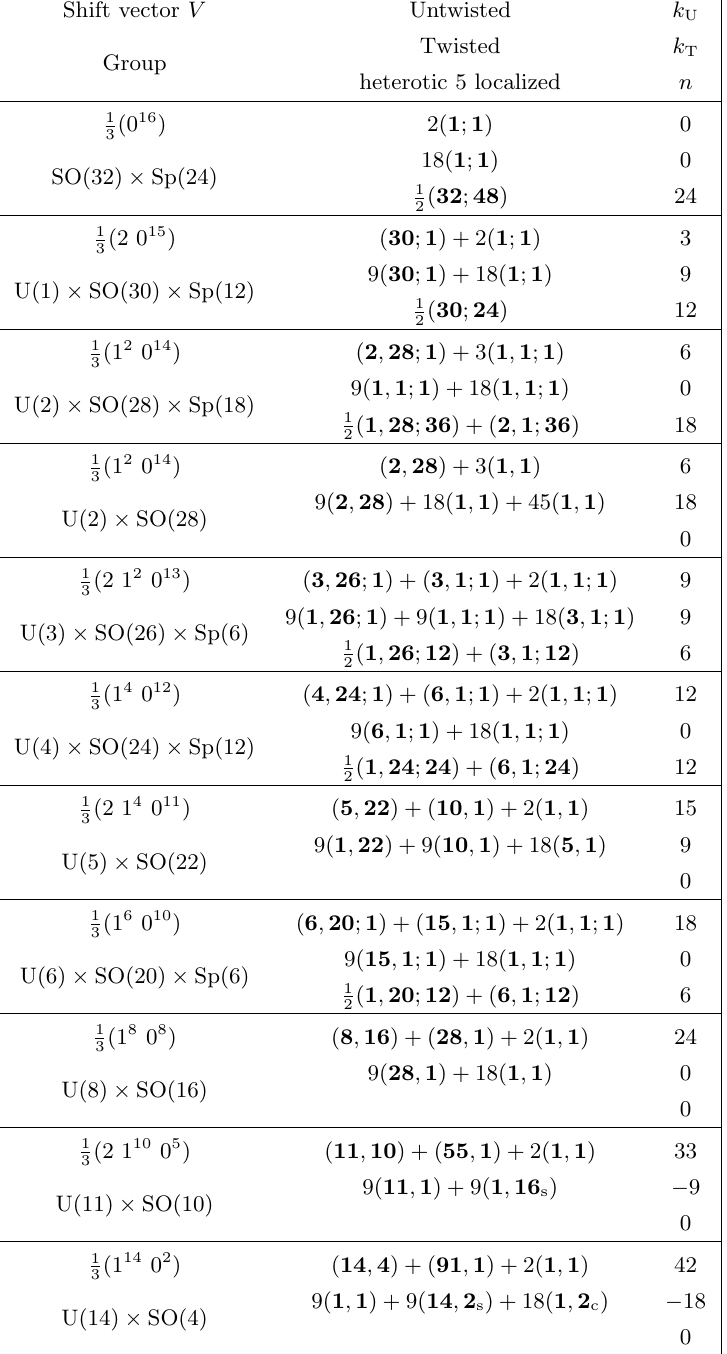
Table 1 . Perturbative ( n = 0) and non-perturbative ( n 6 = 0) vacua of SO(32) string on T 4 = Z 3 orbifold. The parameters k U ; k T ; n are respectively instanton numbers in the untwisted and twisted sectors, and the number of heterotic 5-branes, satisfying k U + k T + n =